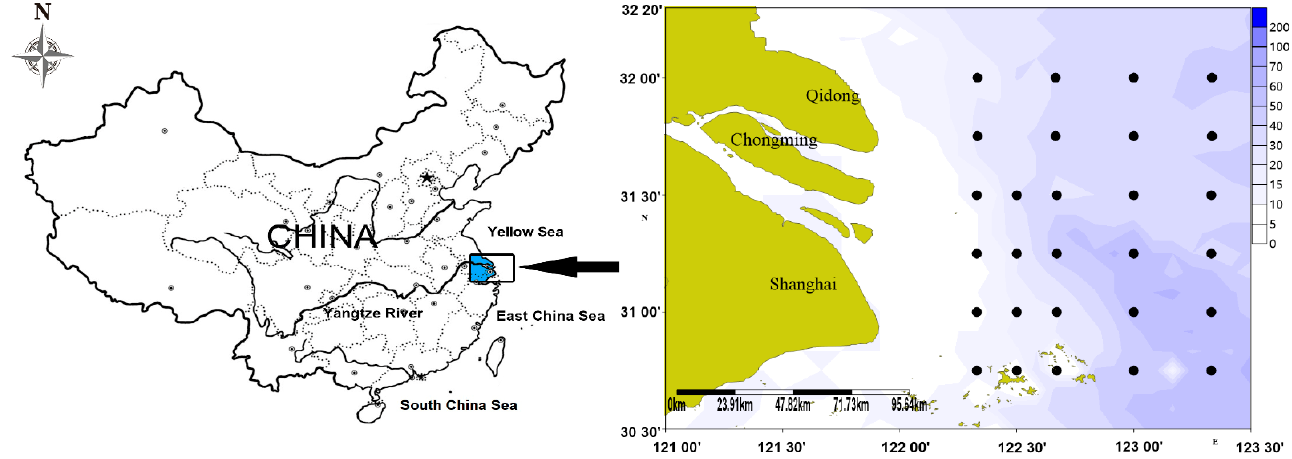
Figure 1. Sampling stations in the Yangtze Estuary’s adjacent waters. The background color indicates the depth variation.